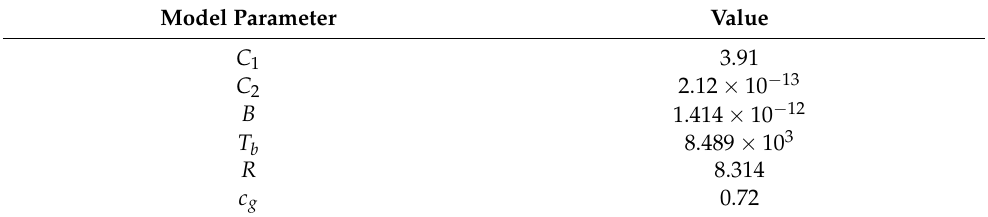
Table 4. Parameter values used for the Castro–Macosko viscosity model.